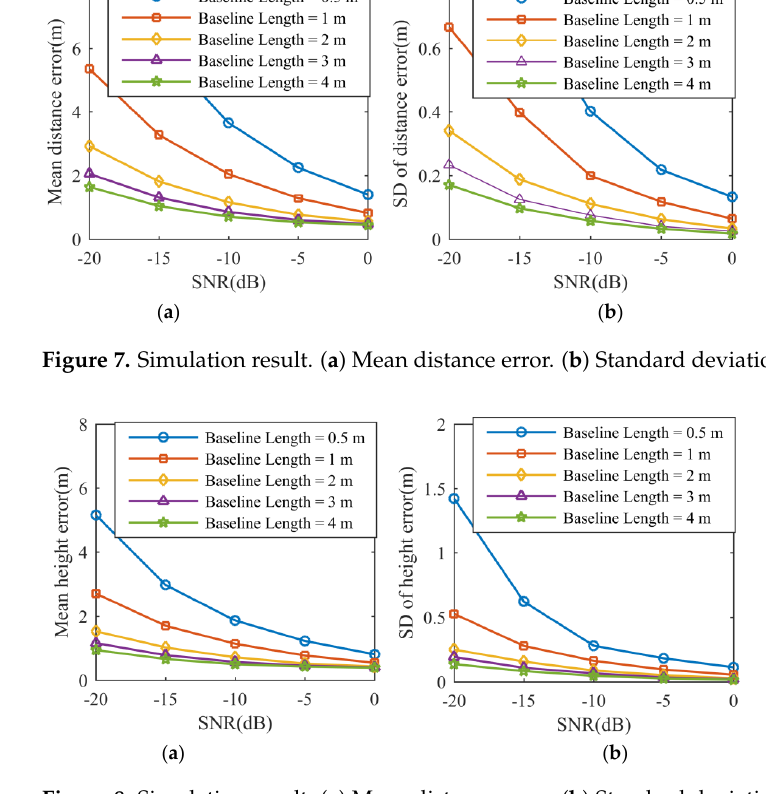
Figure 8. Simulation result. ( a ) Mean distance error. ( b ) Standard deviation of distance error.